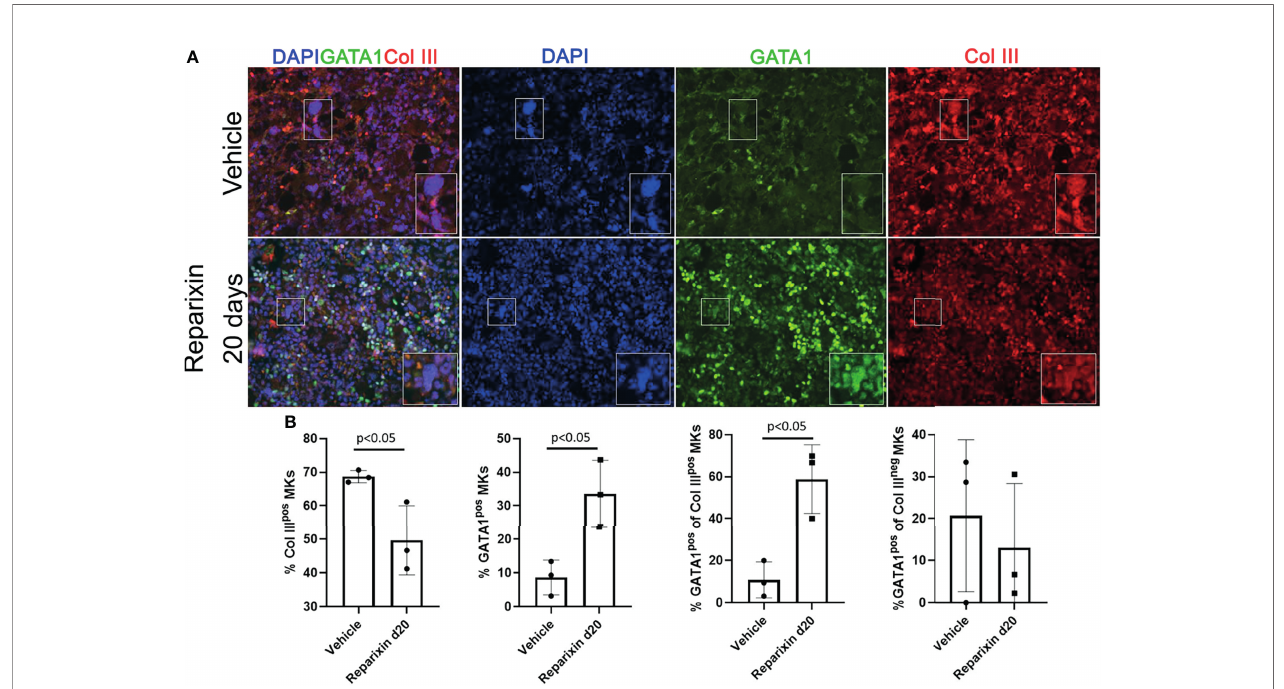
FIGURE 10 | Reparixin increases the GATA1 content in the MK subpopulation that express high levels of Col III. (A) Double immuno fl uorescence staining with anti- GATA1 (FITCH-green) and Col III (TRITCH-red) antibodies of BM sections from representative Gata1 low mice treated with either vehicle or Reparixin for 20 days. Magni fi cation ×400. The rectangles indicate a representative MK shown at greater magni fi cation on the bottom right of each panel. (B) Frequency of MKs positive for Col III (Col III pos MKs), for GATA1 (Gata1 pos MKs) and of the subsets of MKs positive or negative for Col III that were also positive for GATA1, respectively. Data are presented as Mean (± SD) and as values for individual mouse (each mouse a dot). Statistical analyses were performed by One-way ANOVA. P < 0.05 was considered statistically signi fi